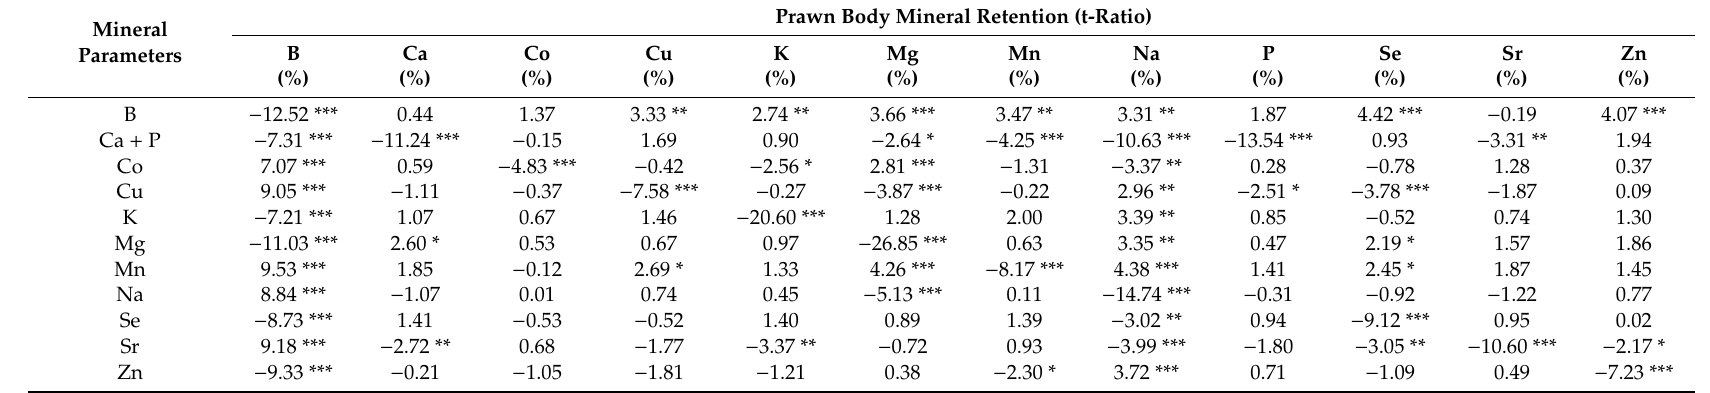
Table A6. E ff ect of dietary mineral inclusions on prawn body mineral retention (%) using two-level screening analysis. PB statistical values for each mineral is outlined. t-ratios with asterisks (*, **, ***) denote significant p -values defined as * p < 0.05, ** p < 0.01, *** p <